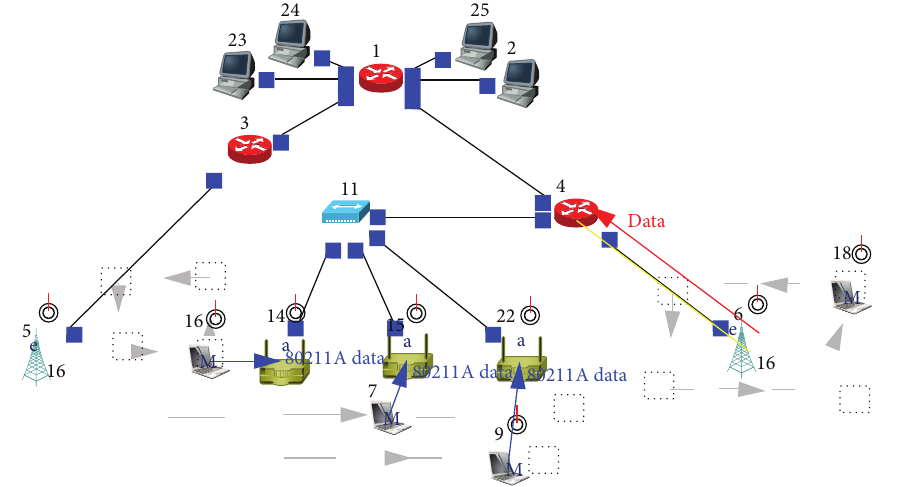
Figure 10: Screenshot from simulator for proposed scheme.